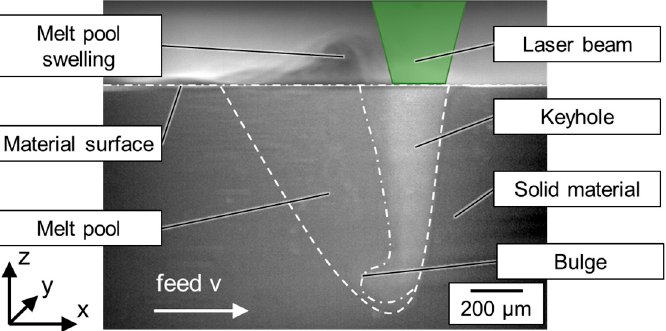
Figure 3. High-speed synchrotron X-ray image of laser beam welding of Cu-ETP with a 515 nm- wavelength laser at a 1 kHz frame rate (P L = 4000 W, v = 200